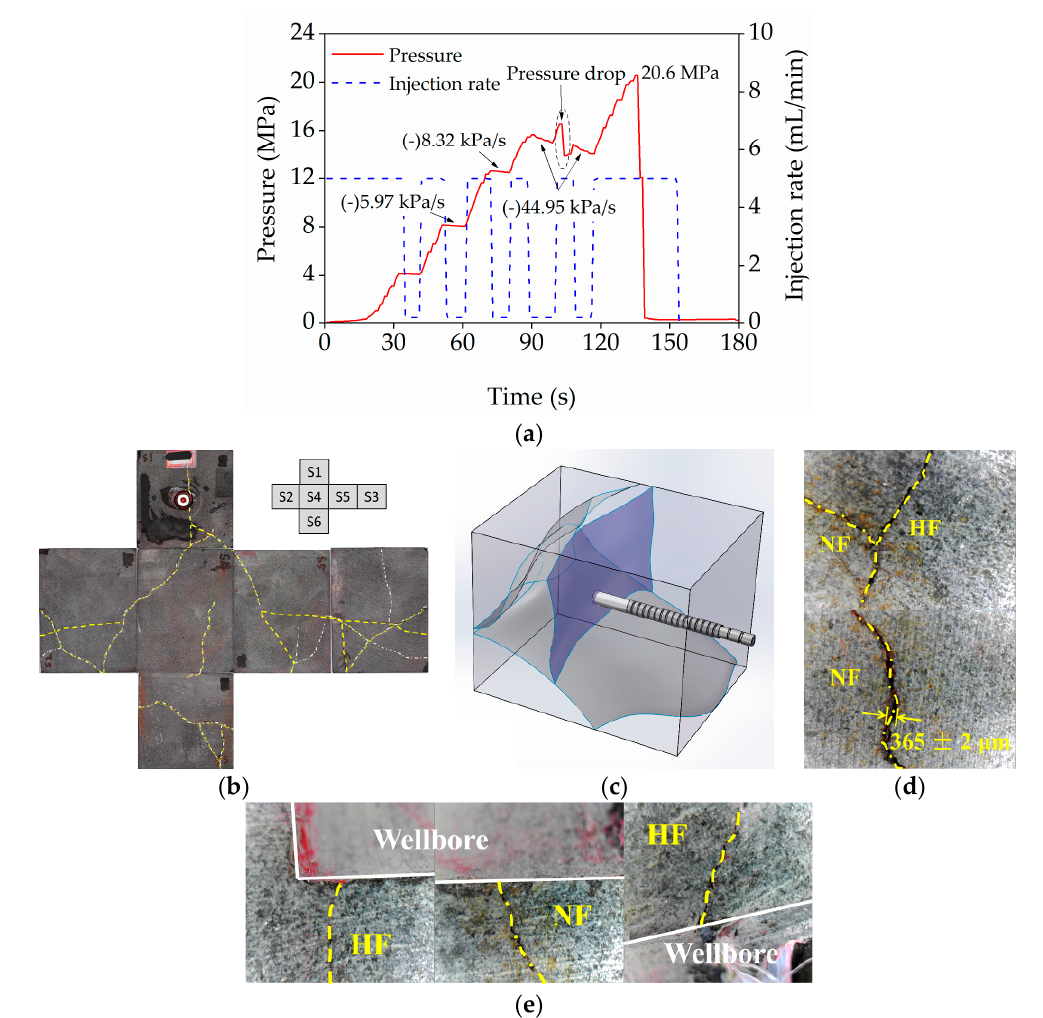
Figure 14. Fracture details of specimen No. 9: ( a ) Pressure curve, ( b ) distribution on the surface, ( c ) internal reconstruction, and ( d,e ) microscopy images.